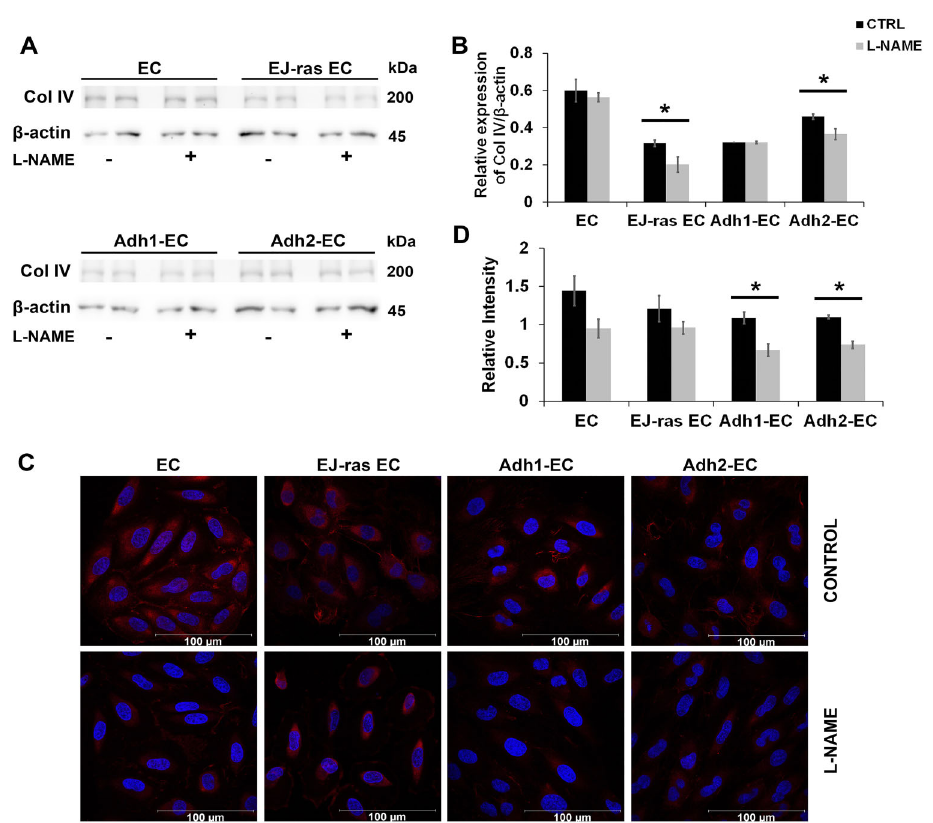
Figure 5. L-NAME treatment decreased collagen IV expression in EC-derived cell lines. A , Western blot images of collagen IV expression after nitric oxide (NO) release inhibition in EC, EJ-ras EC, Adh1-EC, and Adh2-EC cells. B , Histogram depicting collagen IV protein levels normalized to b -actin. C , Immuno fl uorescent analysis of collagen IV by immunocytochemistry of EC, EJ-ras EC, Adh1-EC, and Adh-2 EC cells after L-NAME treatment (scale bar 100 m m). D , Histogram depicting collagen IV protein levels normalized by DAPI fl uorescence. Collagen IV was stained with anti-collagen IV antibody followed by secondary Alexa Fluor 633-labelled antibody (red). Nucleus is stained with DAPI (blue). Each fi gure shows the best image of two experiments. CTRL: Control; EC: parental endothelial cells; EJ-ras EC: EJ-ras transfected endothelial cells; Adh1-EC and Adh2-EC: anoikis-resistant endothelial cells. Data are reported as means ± SE. *P o 0.05 compared to control ( t -test).